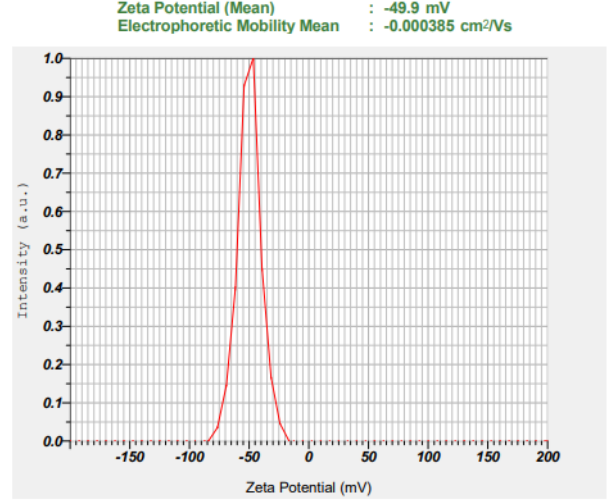
Figure 5. Zeta potential of optimized batch (NC).